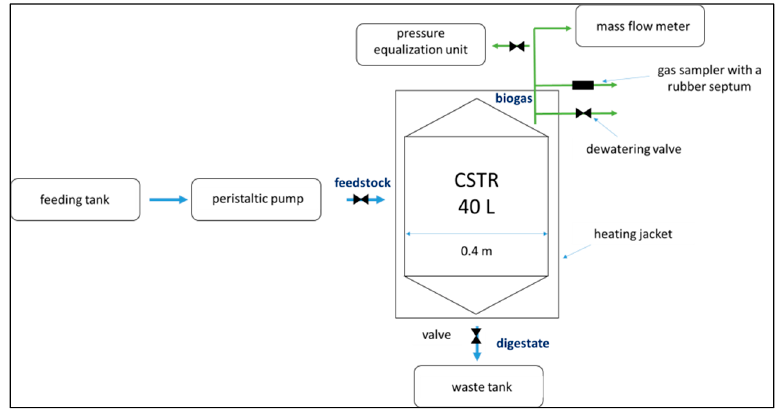
Figure 1. The scheme of laboratory installation.